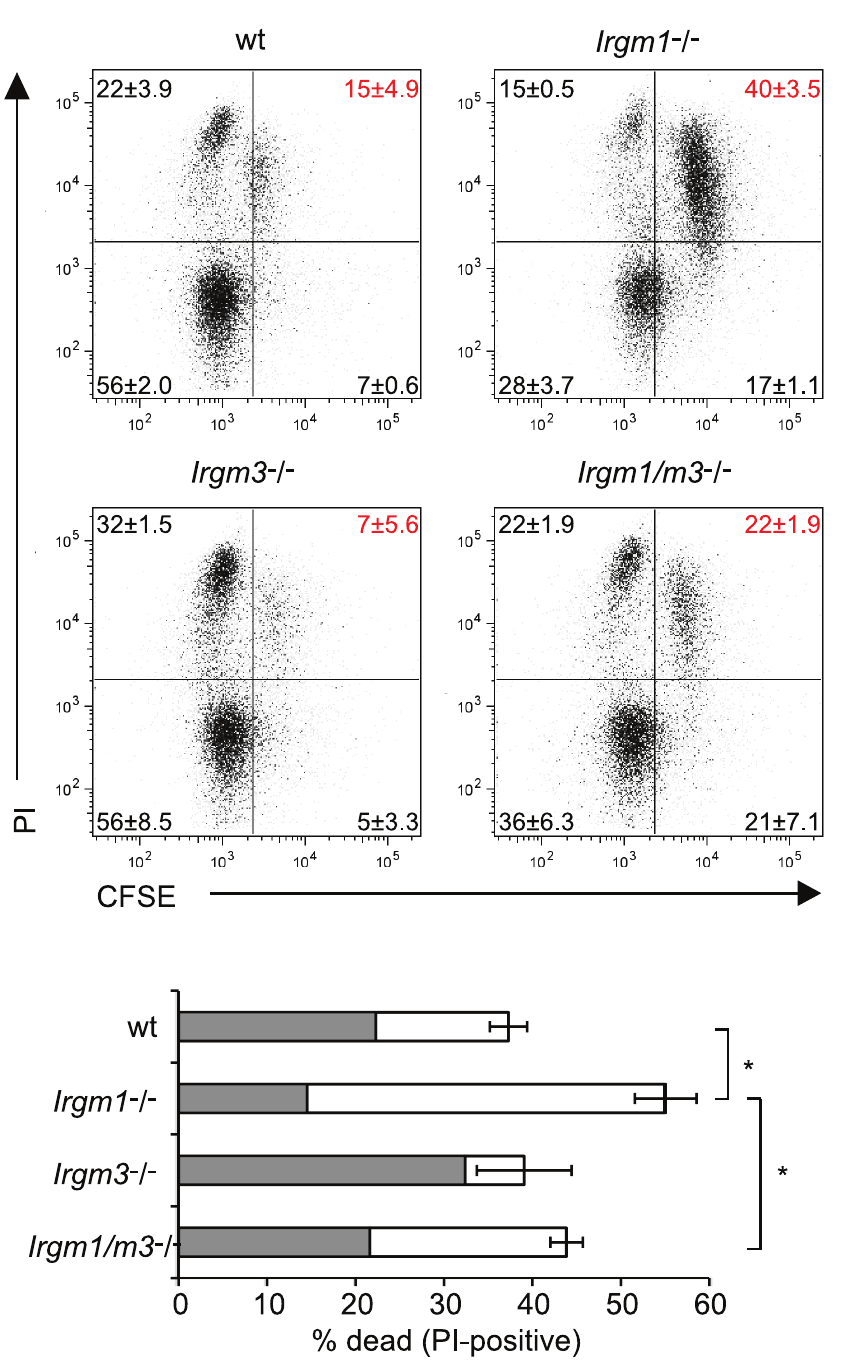
Figure 3. Concomitant deletion of Irgm3 rescues the cell death phenotype of Irgm1 -/- CD4 + T cells. Flow cytometry of CFSE-labeled wildtype, Irgm1 -/- , Irgm3 -/- and Irgm1/m3 (-/-) CD4 + T cells that had been activated with anti-CD3 and anti-CD28 antibodies in the presence of IL-2 for 72 hours and were subsequently stained for dead cells with propidium iodide. Percentages and standard deviations are given for each quadrant (upper panel). The total percentage of propidium iodide positive cells is shown for each genotype. The filled area of the bar indicates the fraction of CFSE low cells and the open area marks the fraction of CFSE high cells (lower panel). Data are representative of three independent experiments. Statistical significance for the percentages of total cell death is indicated as *, p , 0.05.